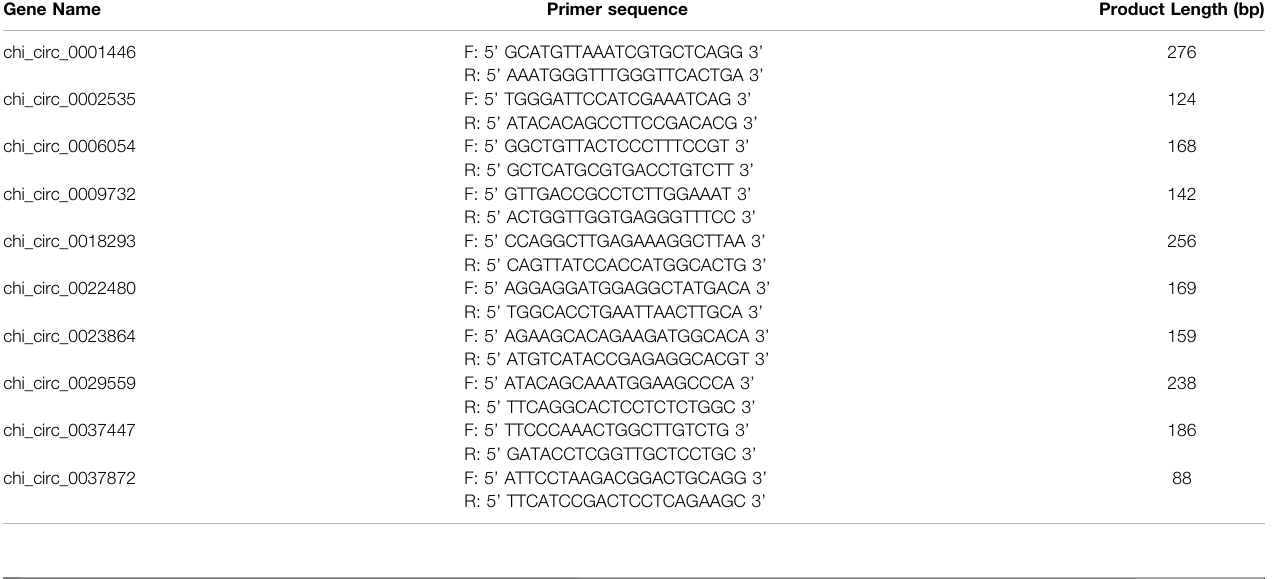
TABLE 1 | Information on real-time quantitative polymerase chain reaction primers and ampli fi cation product sizes of the selected circular RNAs and housekeeping gene.